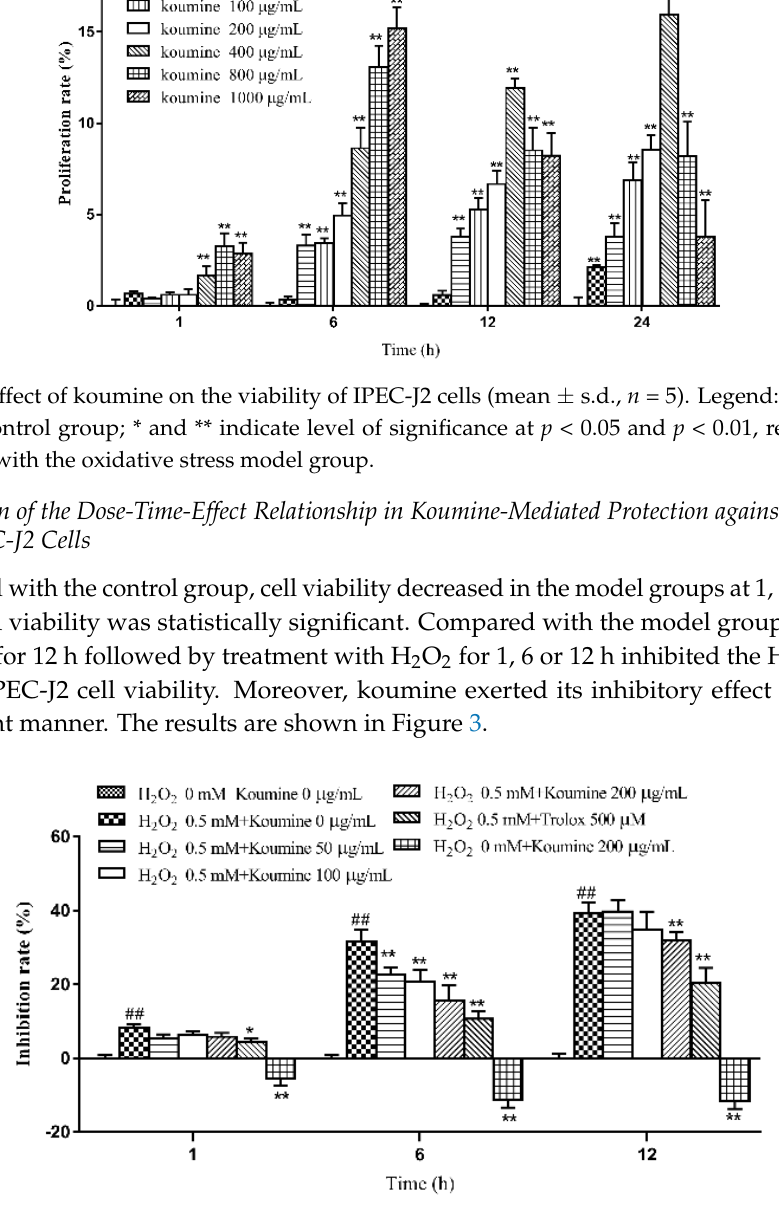
Figure 3. Protective effect of koumine on the viability of IPEC-J2 cells exposed to H 2 O 2 (mean ± s.d., n = 5) Legend: ## indicate level of significance at p < 0.01, respectively, compared with the control group; * and ** indicate level of significance at p < 0.05 and p < 0.01, respectively, compared with the oxidative stress model group.